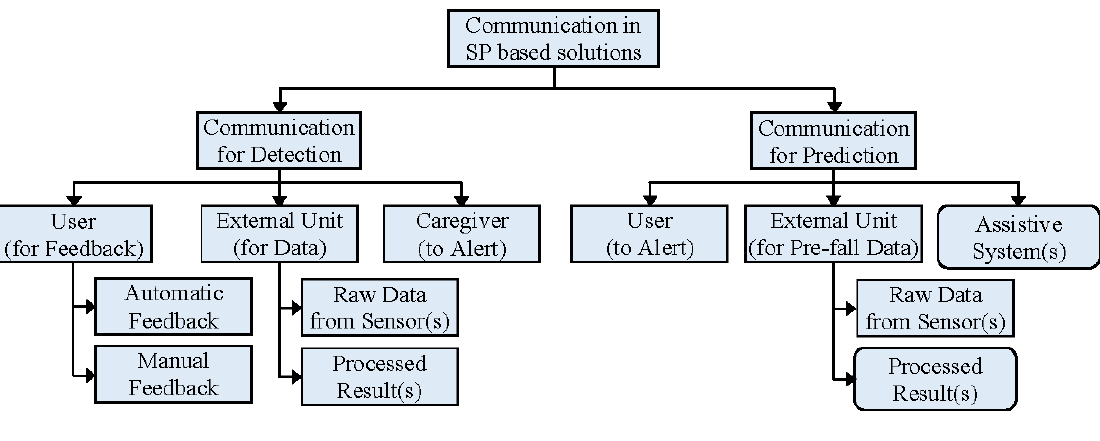
Figure 4. Taxonomy of communication patterns in smartphone-based fall detection and prevention